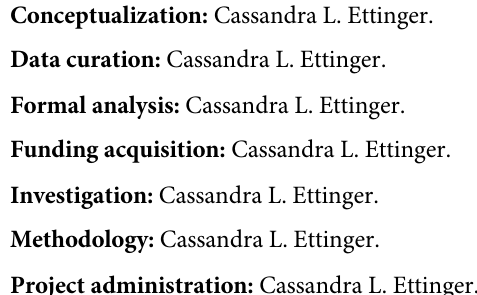
S2 Table. Fungal sequences used in molecular phylogenies found based on top BLAST matches to Zostera marina associated fungal isolates. Here we report the GenBank accession number and taxonomic information (Class, Order, Molecular ID) for each fungal 28S rRNA gene sequence obtained based on top BLAST matches to fungal isolates in Table 1 and used here to generate Figs 3–6 and S7–10. S3 Table. Sequences from fungi isolated from seagrasses used in molecular phylogenies. Here we report information about the fungal 28S rRNA gene sequences used here to generate Figs 3–6 and S7–10 which represent fungal strains previously isolated from seagrasses. We note the seagrass species and tissue material (e.g. leaf, root, matte or rhizomes) the fungus was isolated from, as well as the taxonomic information (Class, Order, Molecular ID, Strain), Gen- Bank accession number and the study of origin for each fungal 28S rRNA gene sequence. S4 Table. Non-seagrass associated fungal isolate sequences from the literature used in molecular phylogenies. Here we report the GenBank accession number and taxonomic infor- mation (Phylum, Class, Order, Species, Strain) for each fungal 28S rRNA gene sequence previ- ously used in James et al [73,74] and used here to generate Figs 3–6 and S7–10. S1 File. R Markdown file of all data analysis performed in R. An R Markdown file of the code used to generate the figures in this